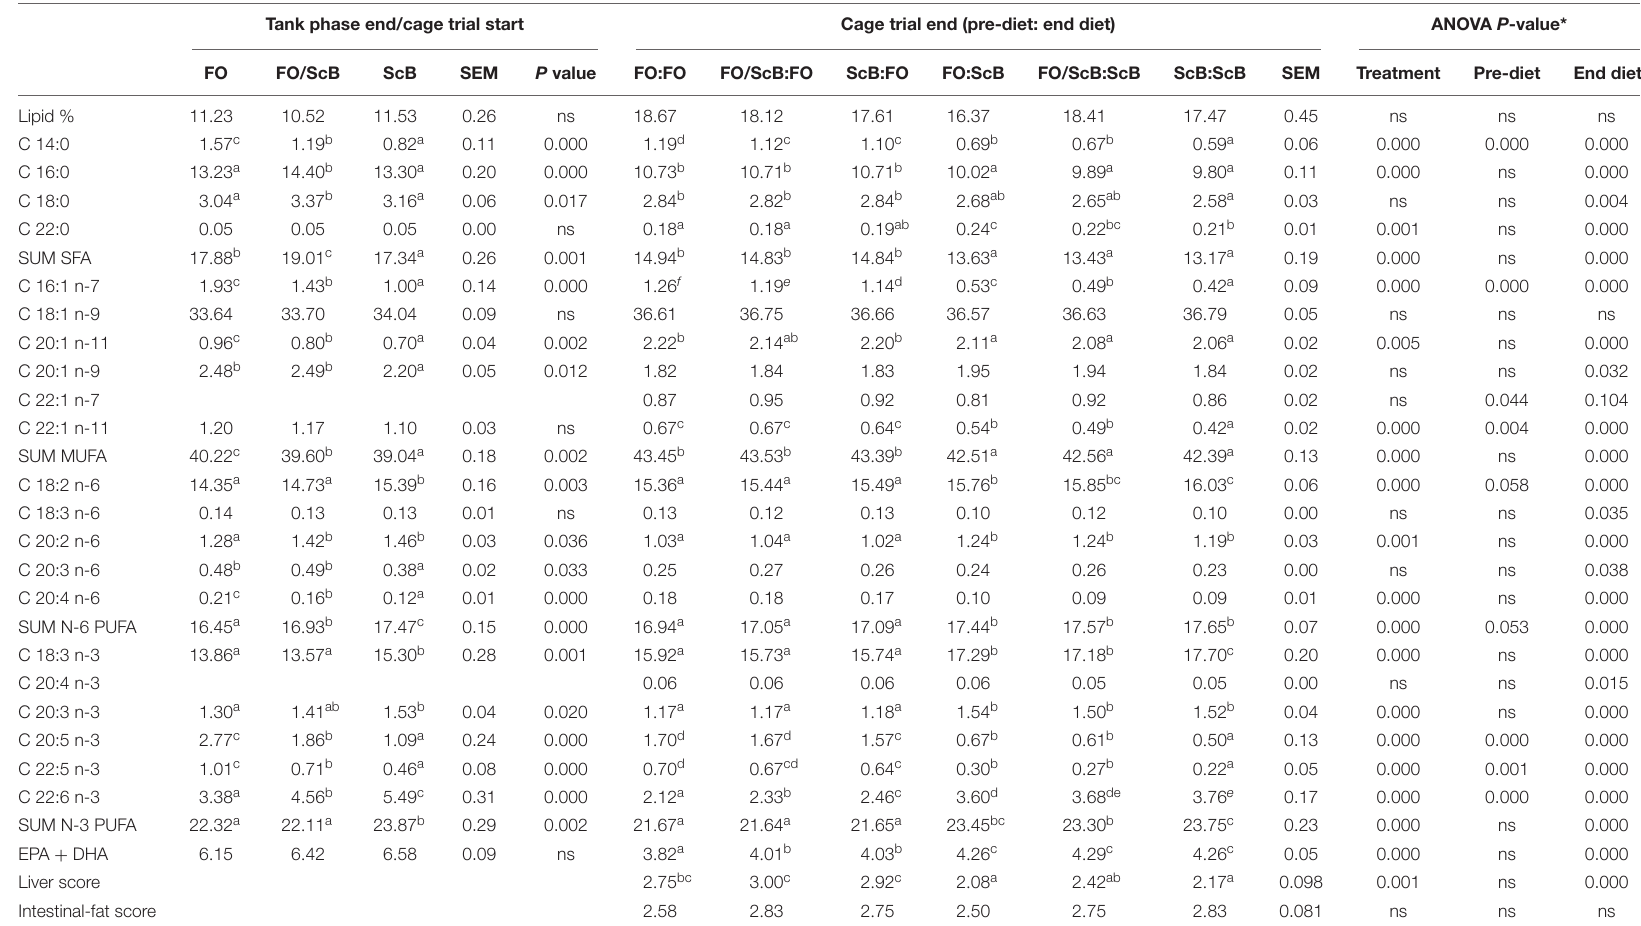
TABLE 5 | Fatty acid composition in filets of A. salmon fed life-long diets supplemented with FO, ScB, or a mix of the two until 0.8 kg body weight and either FO or ScB to slaughter. Tank phase end/cage trial start Cage trial end (pre-diet: end diet) ANOVA P